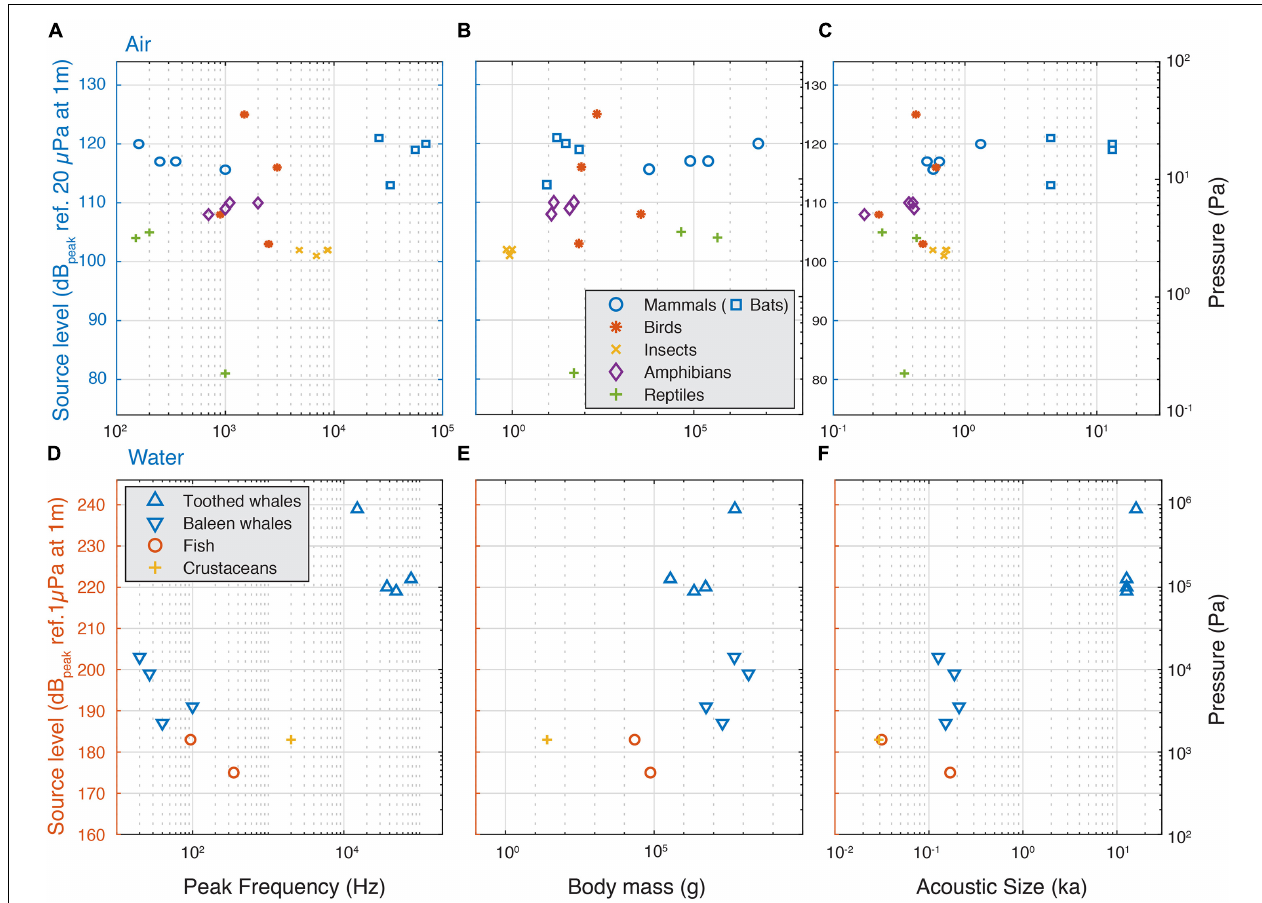
FIGURE 3 | Source levels of the loudest animals do not increase with frequency, weight and acoustic size in air, but do underwater. (A) The highest SLs do not increase with frequency, (B) body mass or (C) ka for animals vocalizing in air and is maximally 125 dB re. 20 µ Pa at 1 m. (D) In aquatic animals, we observe a trend that the highest SLs increase with frequency, (E) body mass and (F) ka, but the sparsity of the data prevents statistical